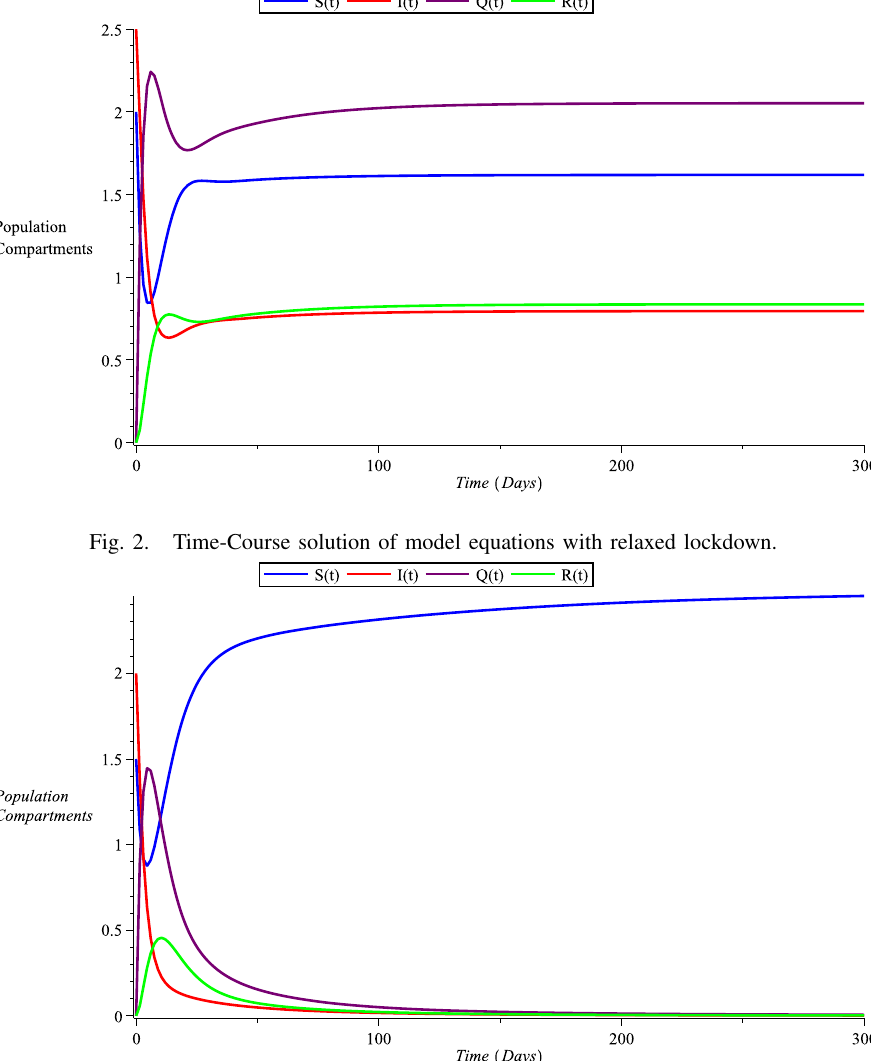
Fig. 2. Time-Course solution of model equations with relaxed lockdown.